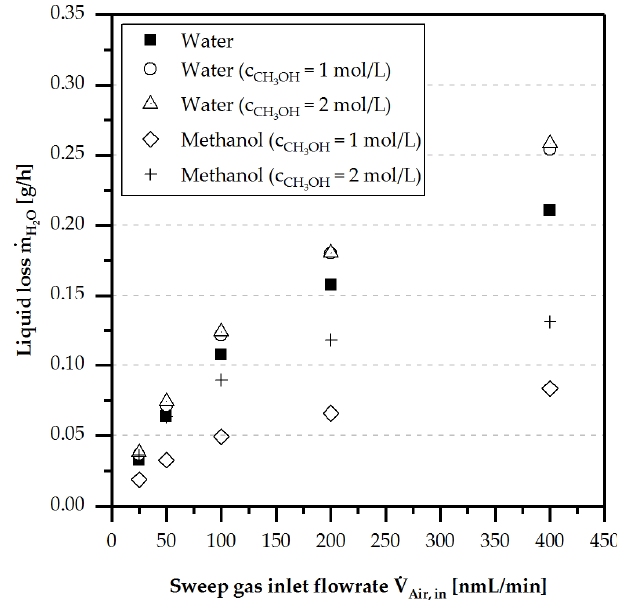
Figure 12. Diffusive liquid loss for water and methanol under single phase flow conditions (liquid) of the porous membrane depending on the sweep gas volume flow for Aspire ® QL217 at 20 °C and V̇ ,, = 5 mL/min